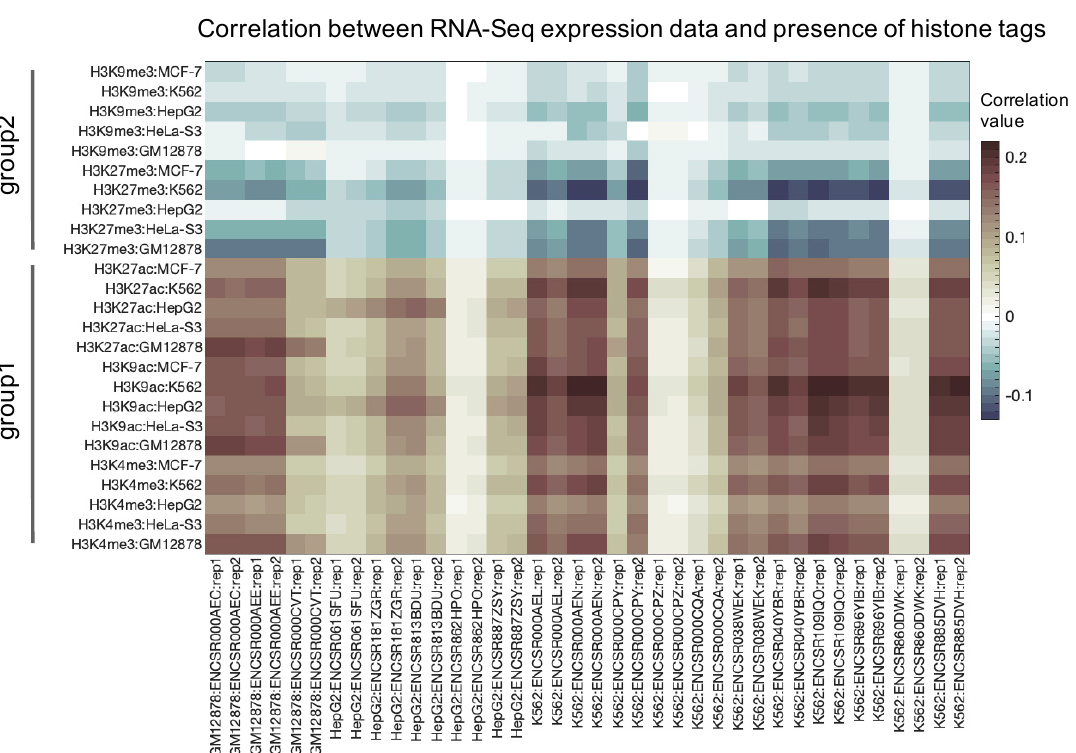
Figure 3. Scatterplots of ( a ) (normalized gene RE-linked enrichment score (NGRE) against NGRE) and ( b ) (normalized pathway involvement index (NPII) against NPII) for five histone tags in Homo sapiens . Each dot represents a single gene. Correlation values are denoted with c and showed within each subplot; all values were statistically significant ( p -value < 0.001). Green squares highlight highly correlated histone tags ( c > 0.75). 3.3. Genes and Molecular Pathways Enriched or Deficient in RE-Linked Regulation Then, the dependencies in pairs GRE/NGRE and PII/NPII were analyzed to identify genes and pathways, respectively, that have their regulation enriched or deficient by RE-linked histone tags (RRE - enriched and RRE - deficient genes/pathways). For that purpose, 25075 human genes and 3121 pathways in analysis were examined respectively on scatter plots with X axis showing GRE score for